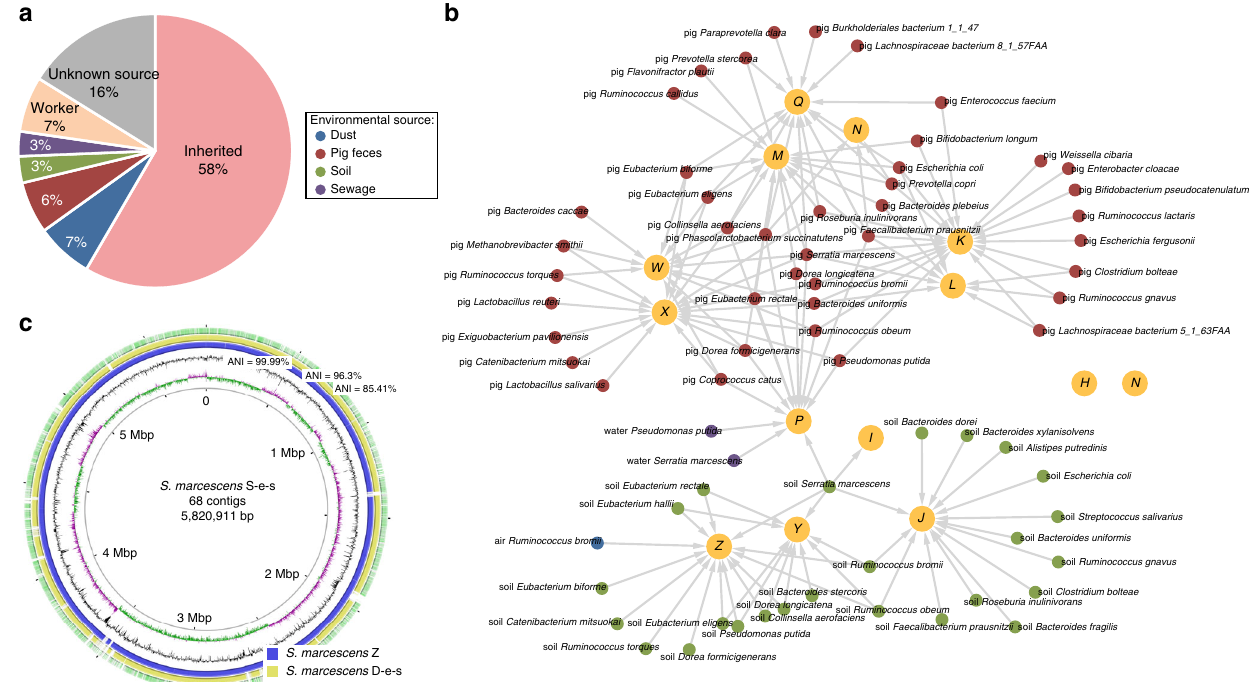
Fig. 3 Transmission of microbes and antibiotic resistance genes from swine farm environments. a Origin of the genes observed in the students ’ gut microbiomes during their stay on the swine farms (time point 3). The majority of the genes did not change (58%), but a large number of the newly observed genes were also identi fi ed in various swine farm habitats, such as the environment (19%, including dust, pig feces, soil, and sewage) and the workers ’ gut microbiota (7%). b Species transmission network from the swine farm environment to the human gut. Larger nodes depict the students (student ID is displayed in the center of each node). Smaller nodes depict transmitted species, color-coded according to environmental types. Connecting arrows represent the transmission events. c Circular representation of the S. marcescens S-e-s draft genome (assembled from a soil sample from swine farm S) and comparison to other genomes. The inner three circles represent the genome scale, G + C skew and G + C content of the S-e-s draft genome. The outer three circles show the portions of the S-e-s genomic region that have close orthologs in other draft genomes: S. marcescens Z (blue, from one student who inherited S-e-s), S. marcescens D-e-s (yellow, from the soil sample taken from swine farm D) and S. marcescens FGI94 (green, the most homologous genome from the NCBI database). High ANI (99.9%) between S. marcescens S-e-s and Z con fi rmed the inheritance relationship between them. Underlying data are provided in the Source Data fi